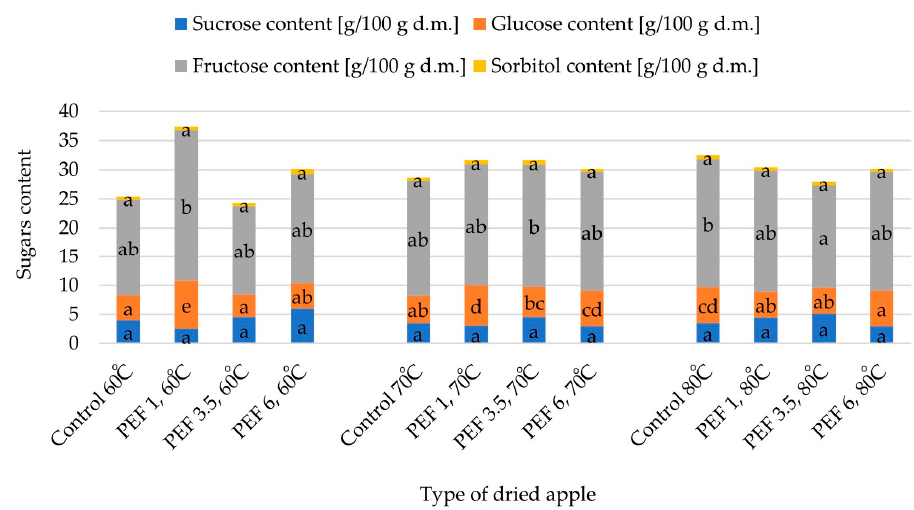
Figure 10. Total sugar content (sucrose, glucose, fructose, and sorbitol) of dried apple tissue obtained using different values for the parameters of pulsed electric field intensity (1, 3.5, and 6 kJ/kg) and hot air drying temperature (60, 70, and 80 ◦ C). The different letters for the one type of sugars shows the signi fi cant di ff erences between the samples ( p < 0.05).